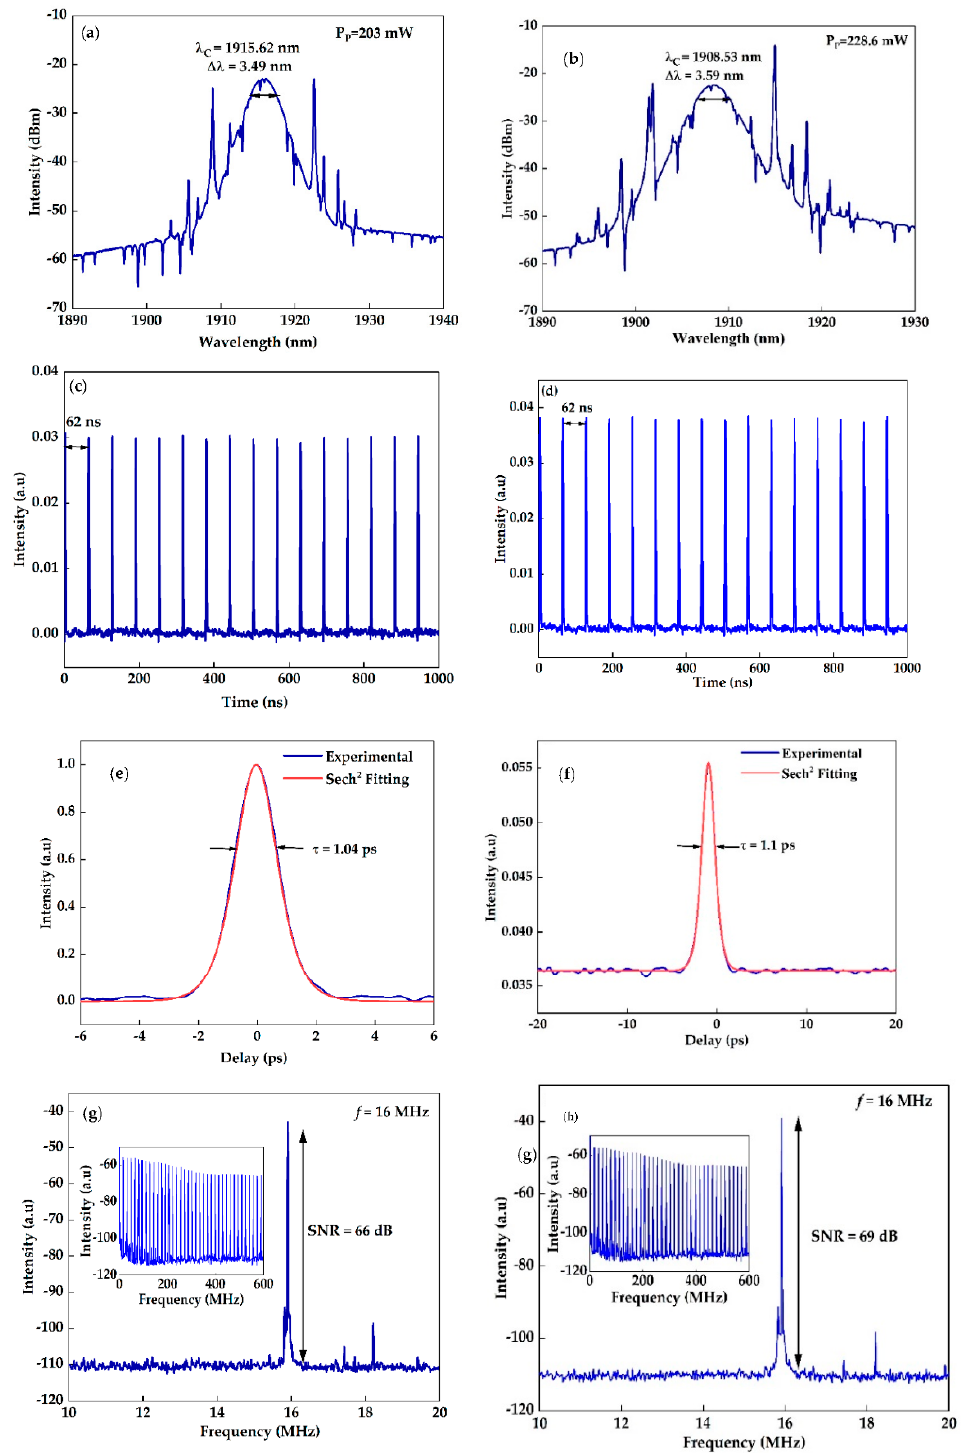
Figure 6. Performance of the mode-locking operation of THDFL at threshold and maximum pump power: ( a , b ) OSA trace; ( c , d ) Output pulse train with pulse-to-pulse separation of 62 ns; ( e , f ) Auto- correlation trace with pulse widths of 1.04 and 1.1 ps; ( g , h ) RFSA where SNR ratios at pump powers of 203 mW and 228.6 mW are 66 dB and 69 dB.